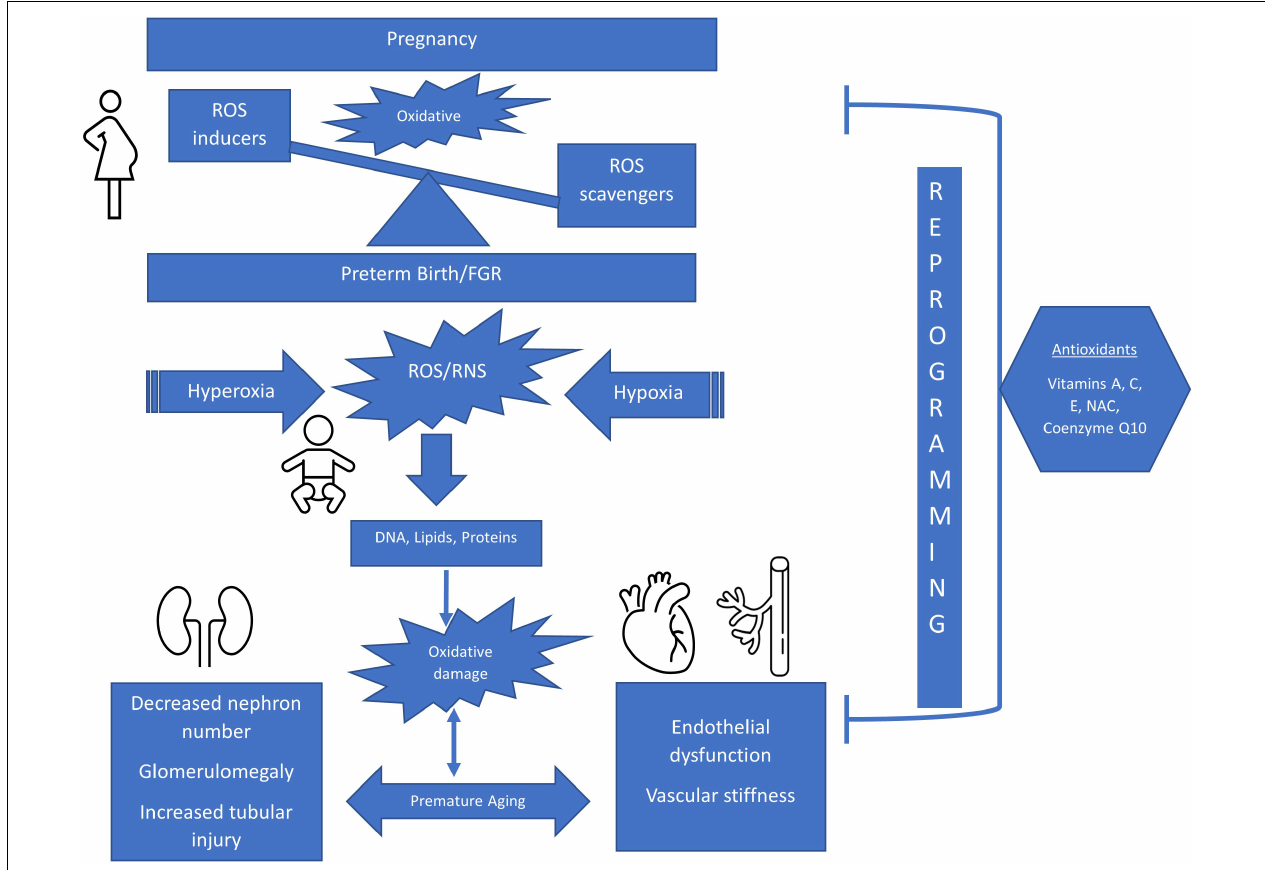
FIGURE 1 | Schematic of The Impact of Perinatal Oxidative Stress on the Developing Kidney and Cardiovascular Systems. ROS, reactive oxygen species; FGR, fetal growth restriction; RNS, reactive nitrogen species; NAC,